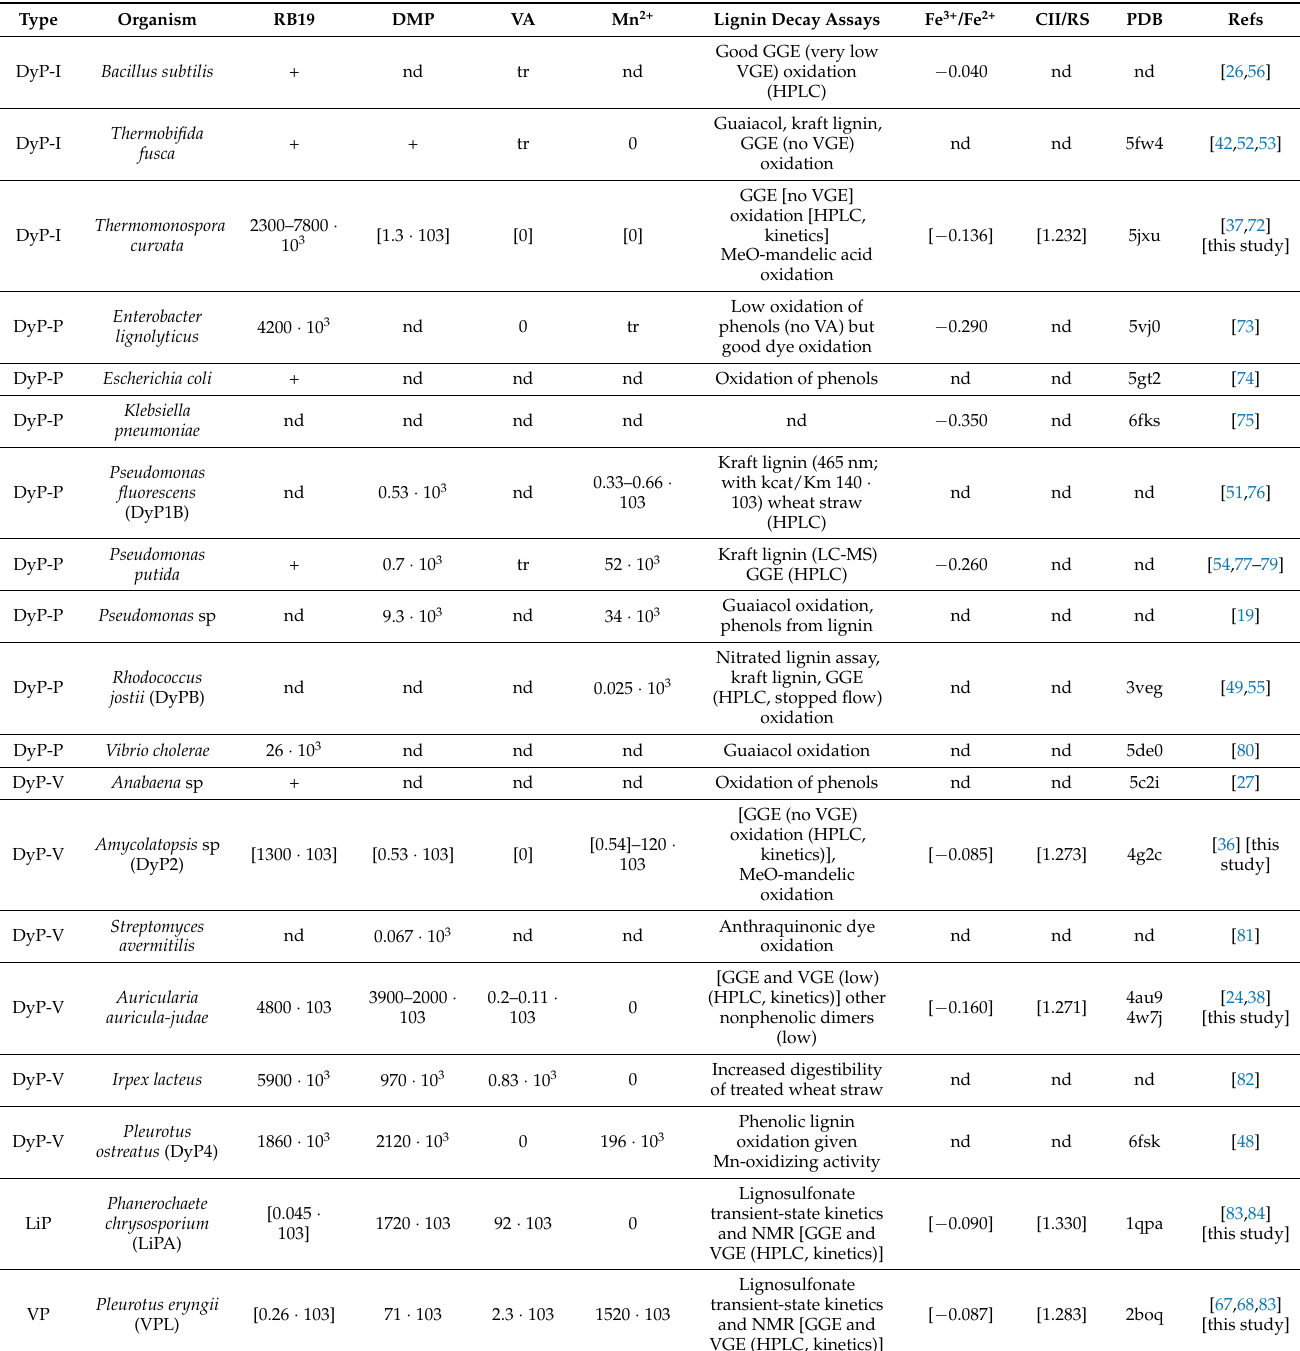
lignin-derived phenols. This activity on phenolic lignin-derived compounds is of interest for the valorization of industrial lignin in the biorefinery context. Table 4. Comparison of catalytic efficiencies (s − 1 · M − 1 ) oxidizing RB19, DMP, VA and Mn 2+ , lignin decay assays (including action on GGE and VGE dimers), and Fe 3+ /Fe 2+ and CII/RS reduction potentials (in V) of 14 bacterial and 3 fungal DyPs compared with LiP and VP (brackets correspond to the present study). PDB crystal structures are also indicated. nd, not determined; tr,